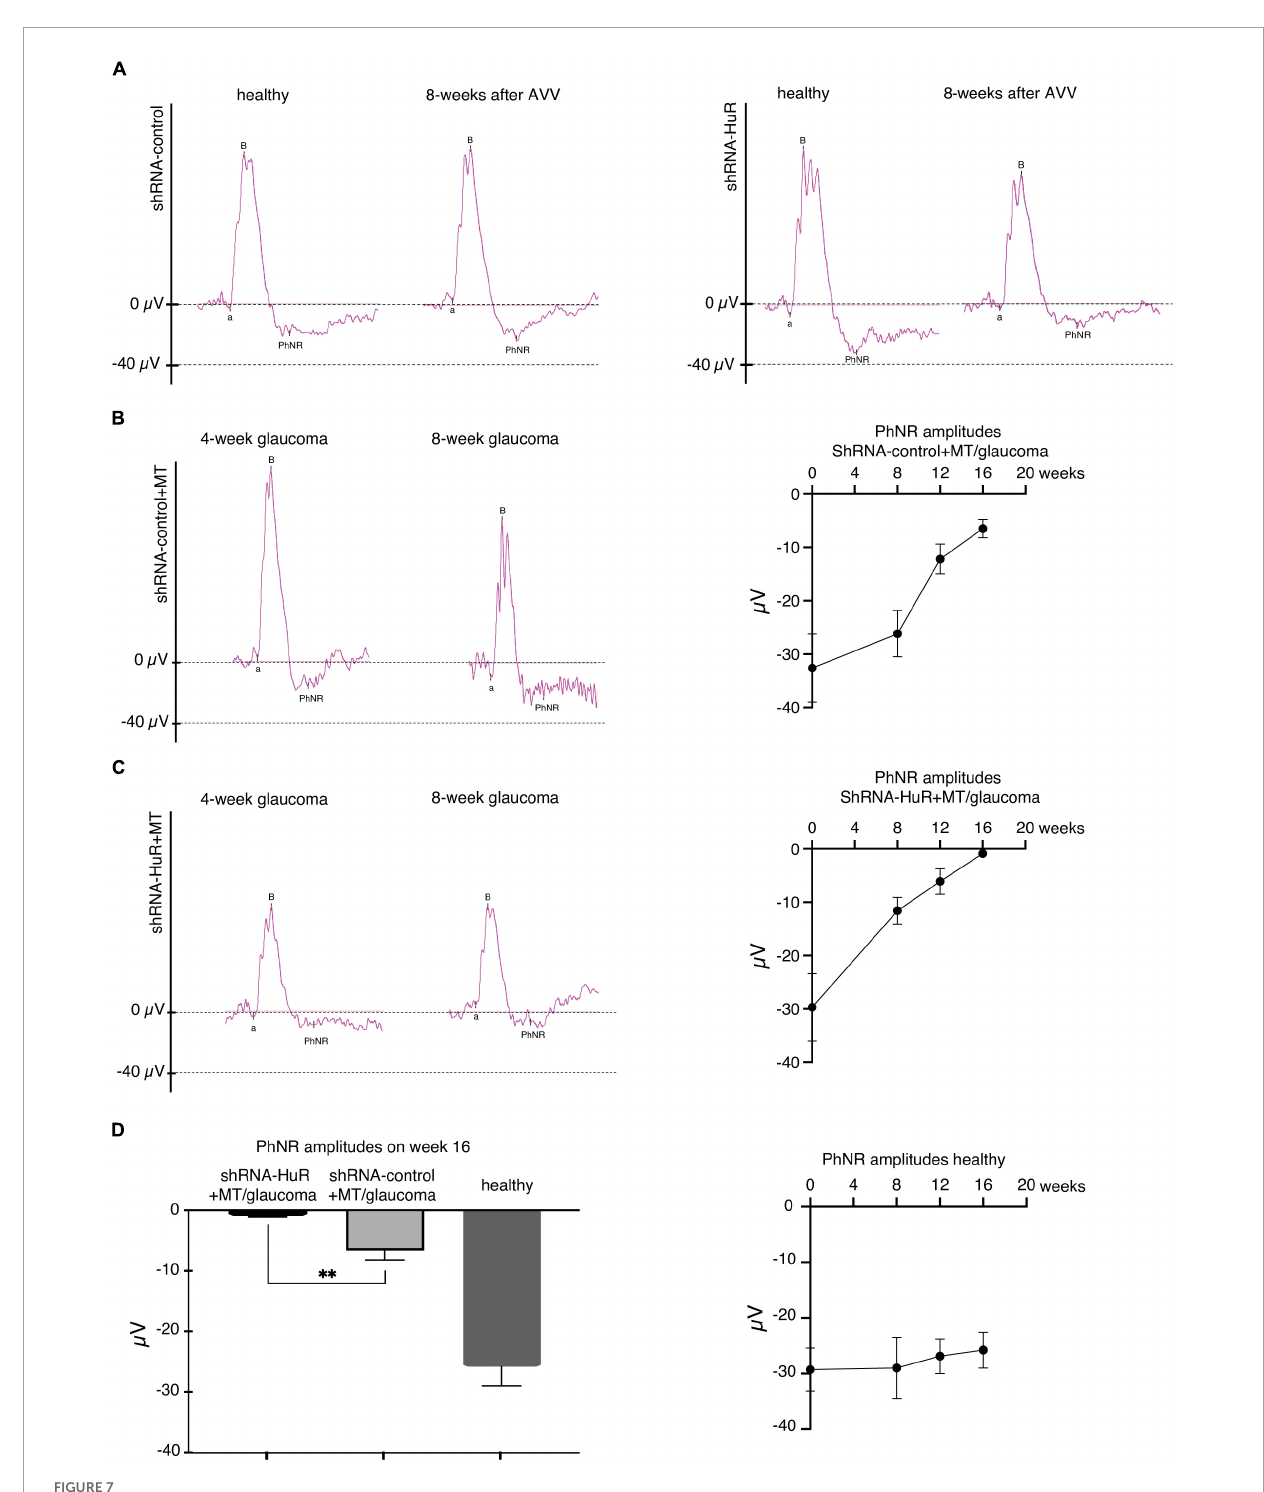
FIGURE7 The exogenous neuroprotection study, functional analysis of RGCs based on the PhNR wave. (A) Silencing of the hur gene using shRNA-HuR leads to the acceleration of the loss of RGC function that is not observed after shRNA-control injection. (B) The effects of glaucoma and MT treatment on RGC function after the shRNA-control injection. (C) The effects of glaucoma and MT treatment on RGC function after the shRNA-HuR injection. Silencing of hur gene leads to almost complete loss of PhNR response despite of applied MT neuroprotective treatment. (D) Statistical analysis of PhNR wave amplitudes 16 weeks after AAV constructs injection, n = 8 animals per group, ∗∗ p < 0.01.